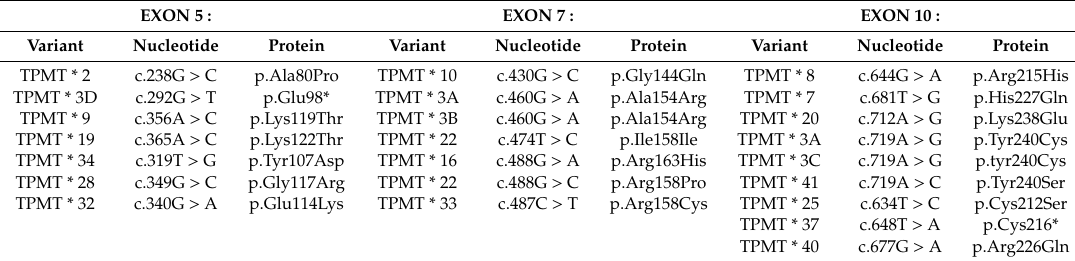
Table 2. Genotyping of the TPMT gene-list of targeted molecular